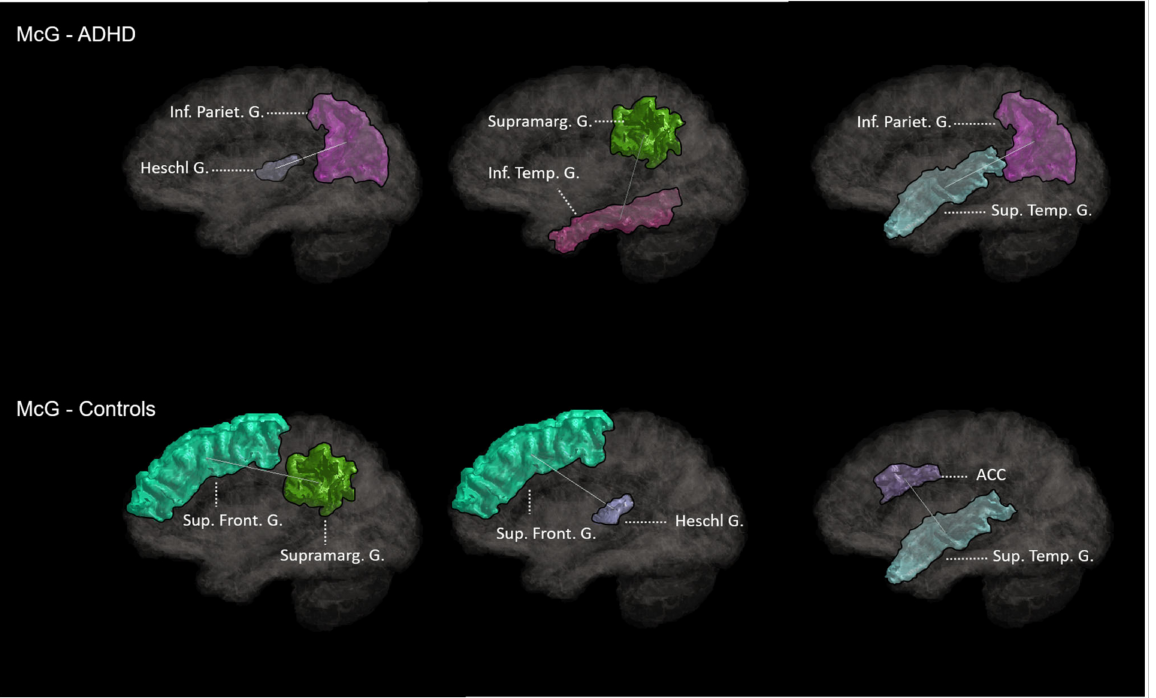
Figure 3. Brain–behavior relationship of integration with structural connectivity for ADHD ( top ) and controls ( bottom ); Abbreviations: Inf. Pariet. G., inferior parietal gyrus; G, gyrus; supramarg. G., supramarginal gyrus; sup. temp. G, superior temporal gyrus; sup. front. G, superior frontal gyrus; Acc, anterior cingulate